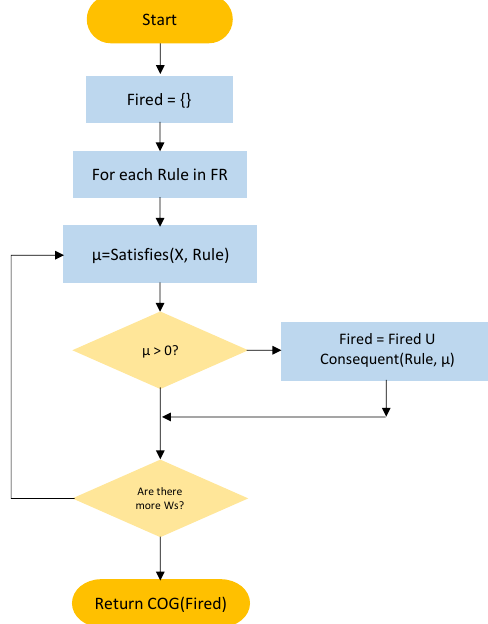
Figure 4. FuzzyForecasting ( fuzzy rules (FR), X , m )